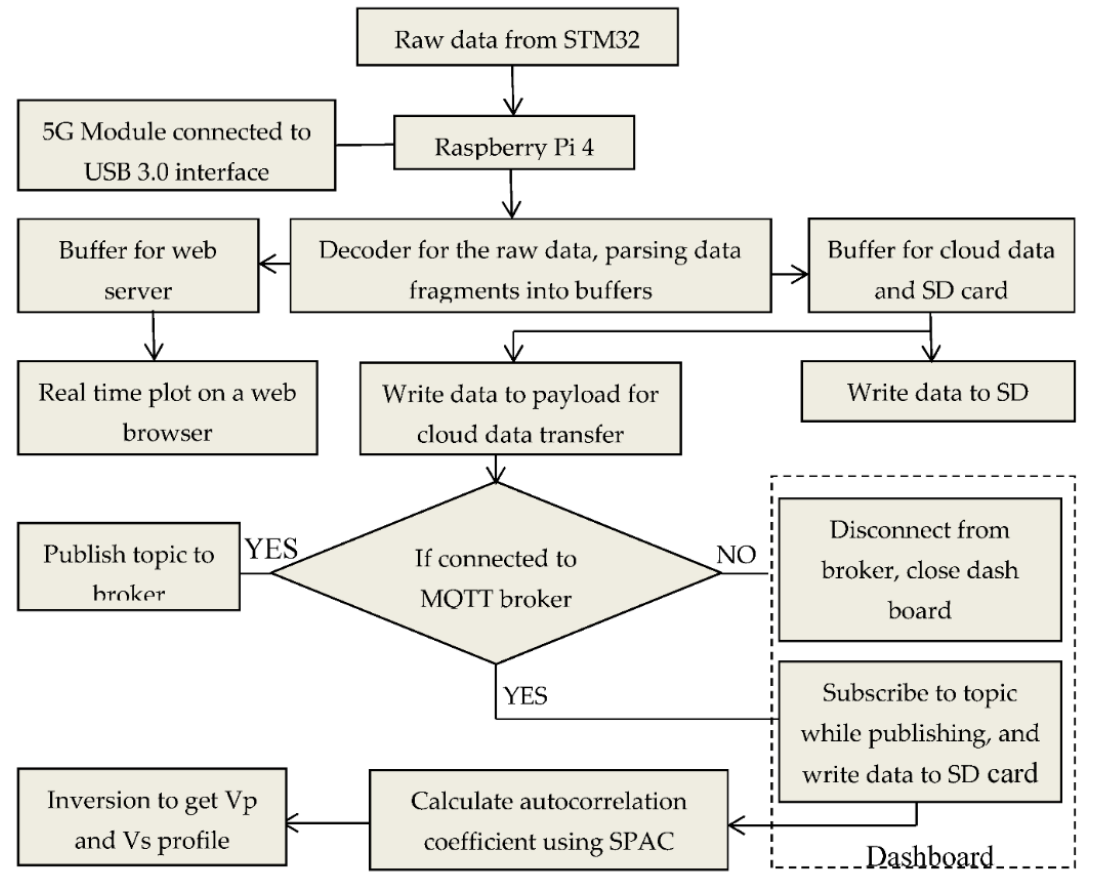
Figure 6. Field testing of the proposed multichannel seismograph. A single traverse of 8 m spread was used for seismic wave tomography. Each geophone was planted vertically with an offset of 1 m from its neighbors.